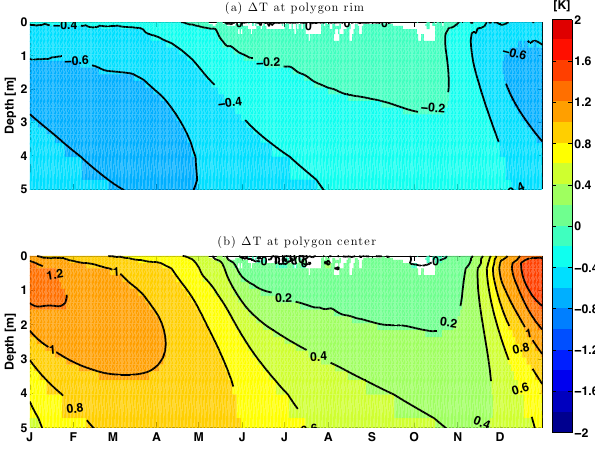
Figure 8. Time series of spatial mean soil tempera- ture differences between “SR = on + physics = 1-D” and “SR = on + physics = 2-D” at polygon rim (a) and polygon center (b) .